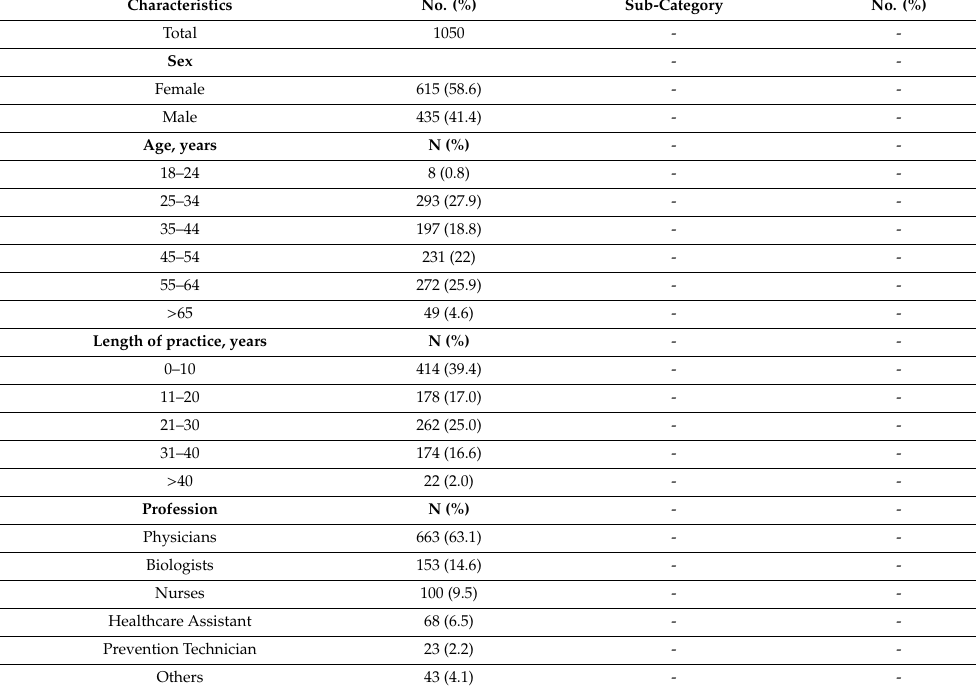
Table 1. Demographic and professional characteristics of Italian public health professionals